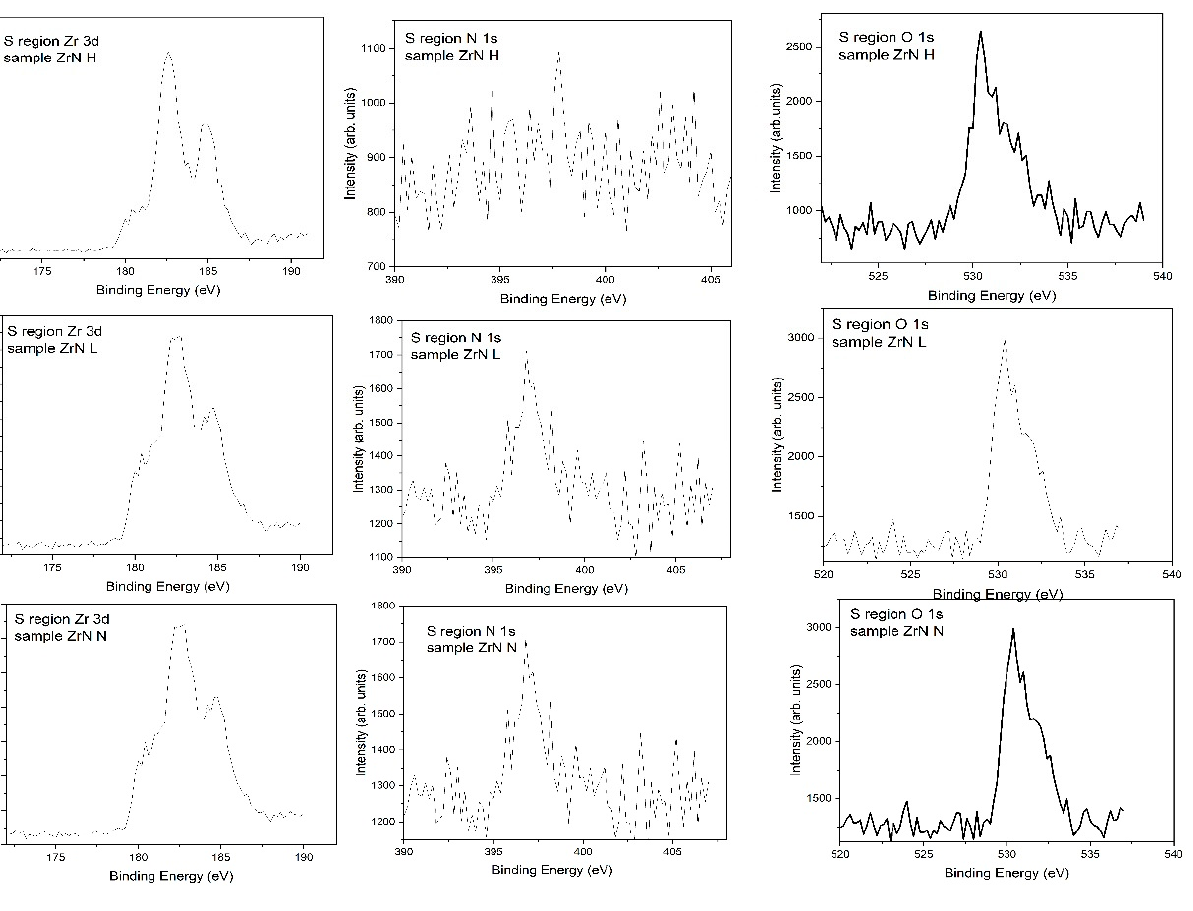
Figure 8. Peak-fitting results of Zr 3d and N1s HR regions level 2 sample ZrN F group2.